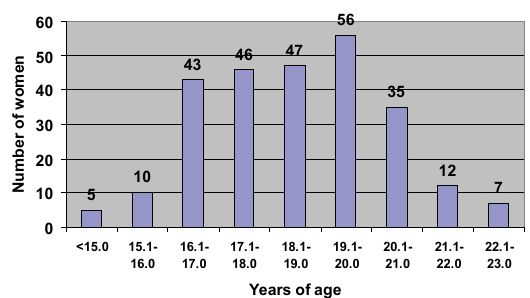
Figure 1. The age of enrolled